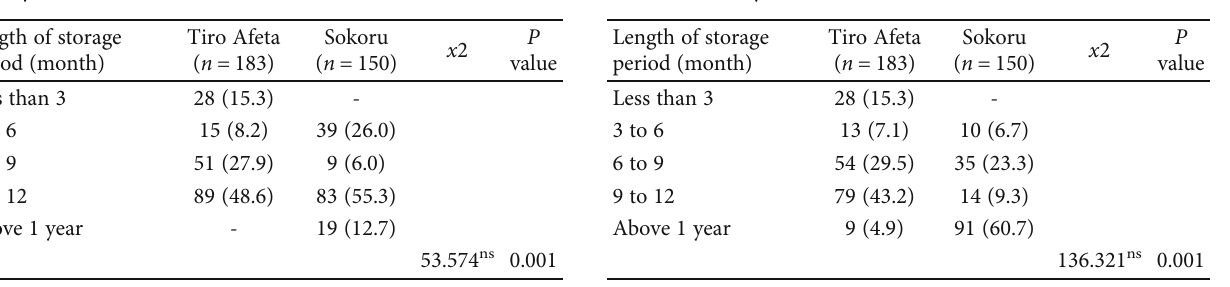
Table 2: Comparison of small-scale farmer ’ s sorghum storage duration in study